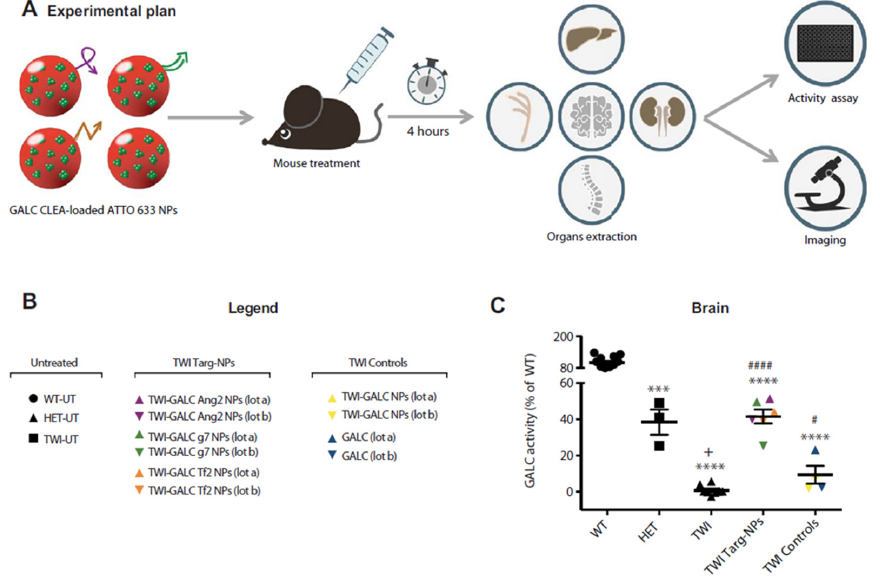
Figure 3. An example of targeting PNPs functionalized with different peptides for the targeting and crossing of the BBB. In this work, the authors showed the functionalization of PLGA nanoparticles with different peptides that are able to cross the BBB and performed an optimized enzyme replacement therapy in vivo. ( A ) Scheme of the experiment. Specific mice with Krabbe disease (TWI) were treated with targeted NPs (GALC Ang2 NPs, GALC g7 NPs, or GALC Tf2 NPs), nontargeted NPs (GALC CLEA NPs), or with the free enzime rm-GALC (GALC). After four hours mice were euthanized, and GALC activity was assayed in extracted brain, sciatic nerves, spinal cord, kidneys, and liver by HMU- β Gal assay. ( B ) Legend. ( C ) Brain GALC activity calculated for each animals. (From Del Grosso et al.) [81]. © The Authors, some rights reserved; exclusive licensee AAAS. Distributed under a Creative Commons Attribution NonCommercial License 4.0 (CC BY-NC) http: //creativecommons.org/licenses/by-nc/4.0/ (accessed on 2 December 2022). *** p < 0.001 HET versus WT **** p < 0.0001 TWI, TWI targ-NPs, and TWI control versus WT # p < 0.05 TWI control versus TWI #### p < 0.0001 TWI-TARG-NPs versus TWI + p < 0.05 TWI versus